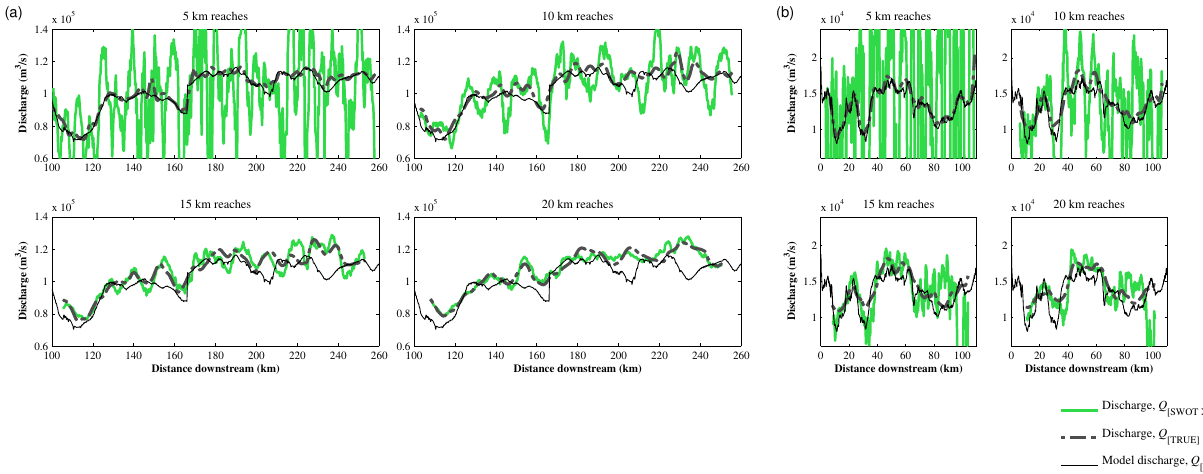
Figure 11. Discharge estimates accounting for slope errors but neglecting width, depth, and friction errors for reach lengths between 5 and 20km for the (a) Solimões and (b) Purus rivers. Plots show cycle 18 (high water), overpass 6.